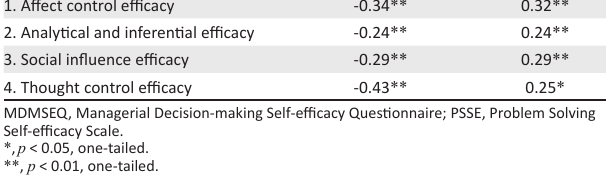
TABLE 3: Zero-order intercorrelations, factorial dimensionality and internal consistency of MDMSEQ subscales. MDMSEQ subscales